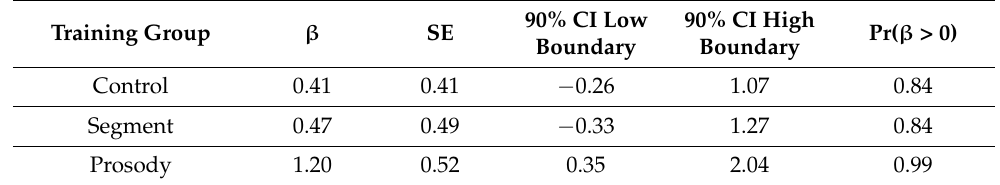
Table 3. Results of the Bayesian mixed model regarding the difference in rise magnitude between recording time points (after training minus before training) in the three